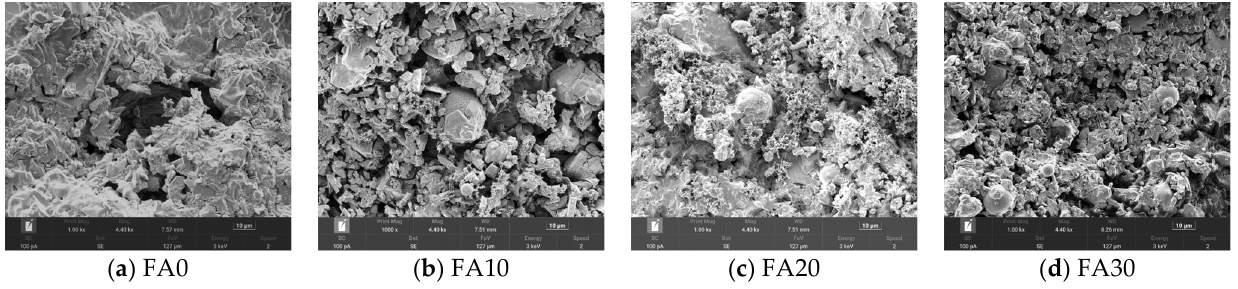
Figure 9. SEM images of fly ash-modified MPC cured for 28 days at 20 °C.